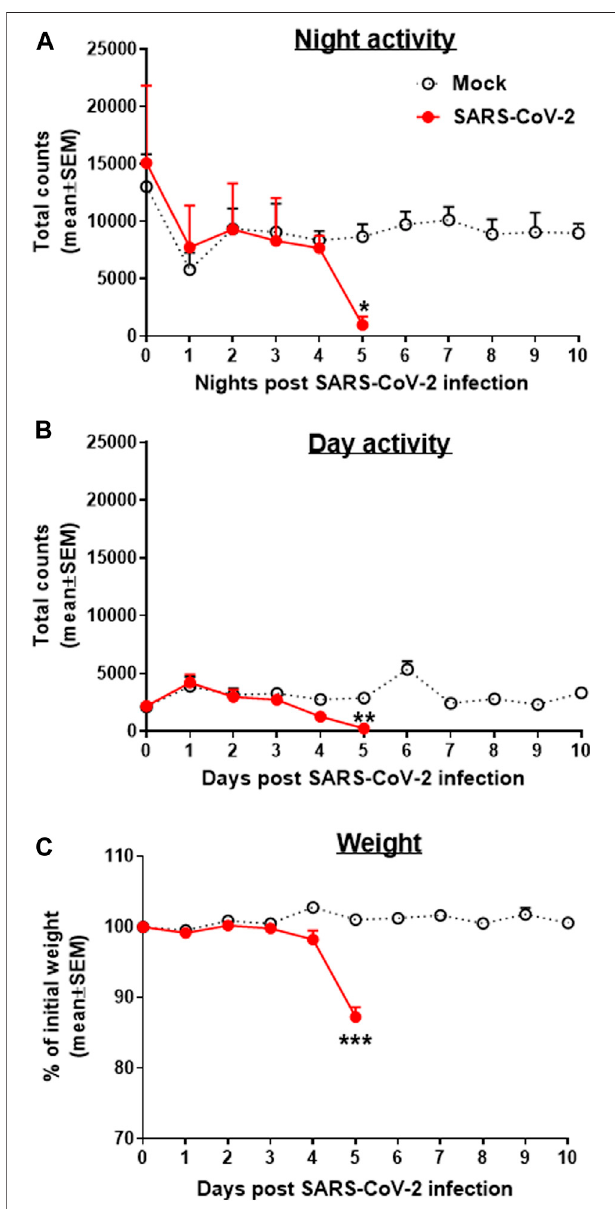
FIGURE 3 | Group activity and weight changes of K18-hACE2 female mice infected with SARS-CoV-2. Total counts of activity during nighttime (5 pm – 5 am, A ) and daytime (5 am – 5 pm, B ) and weight changes (C) over 10 days of mice infected i.n. with 2000 pfu of SARS-CoV-2. None of the infectedanimalssurvivedtheinfection(deathondays6 – 7).Infectionexposure on day 0, n (cid:2) 4 cages/group, 5 mice/cage. * p < 0.05, ** p < 0.01, *** p < 0.001 vs